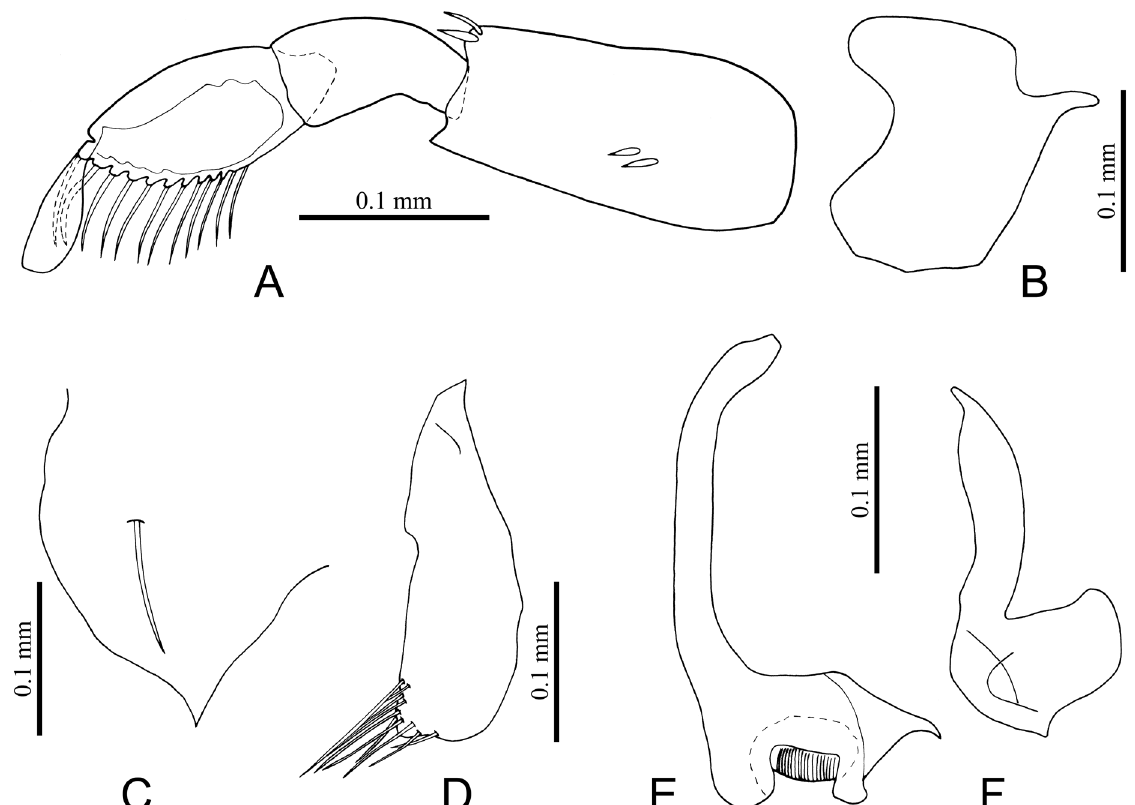
Fig. 11. Morphological features of Micronecta acuminata sp. nov., ♂, paratype (ZVNU). A . Fore leg. B . Prestrigilar flap. C . Median lobe of sternite VII. D . Free lobe. E . Right paramere. F . Left